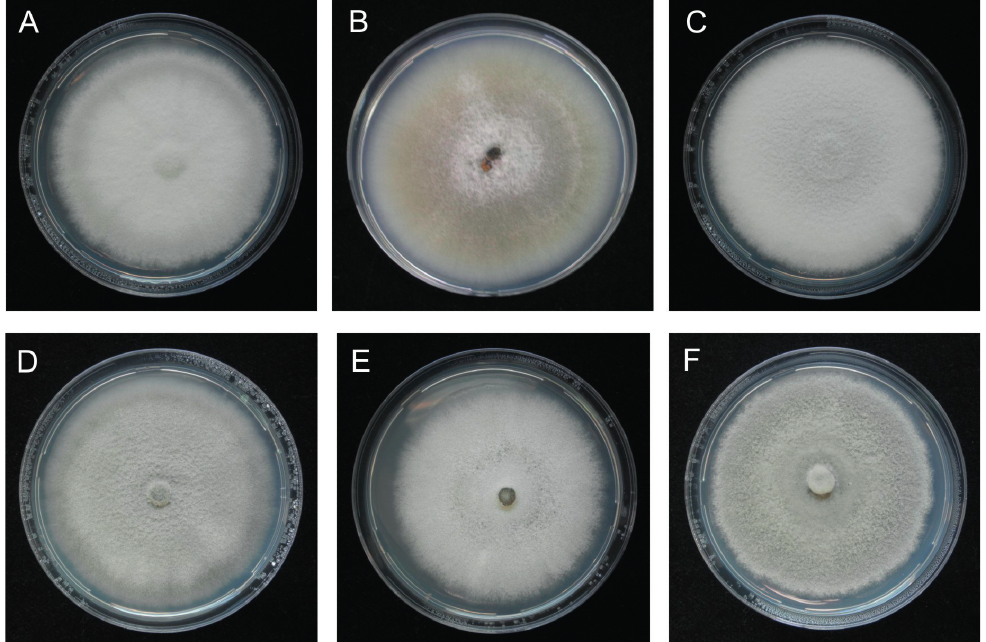
Figure 6. Colony morphology of isolates of Colletotrichum clavatum sp. nov. grown for 14 days on PDA at 24(±1)°C. A, IMI 398855, ex-paratype (olive isolate from Apulia, Italy); B, CBS 193.32, ex-paratype (olive isolate from Greece); C, AZJ (rhododendron isolate from Piedmont, Italy); D, ORA1 (olive isolate from Sardinia, Italy); E, CIRRI (olive isolate from Apulia, Italy); F, OLF97E (olive isolate from Apulia,